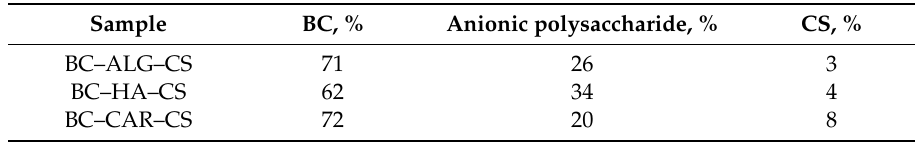
Table 2. Composition of bacterial cellulose